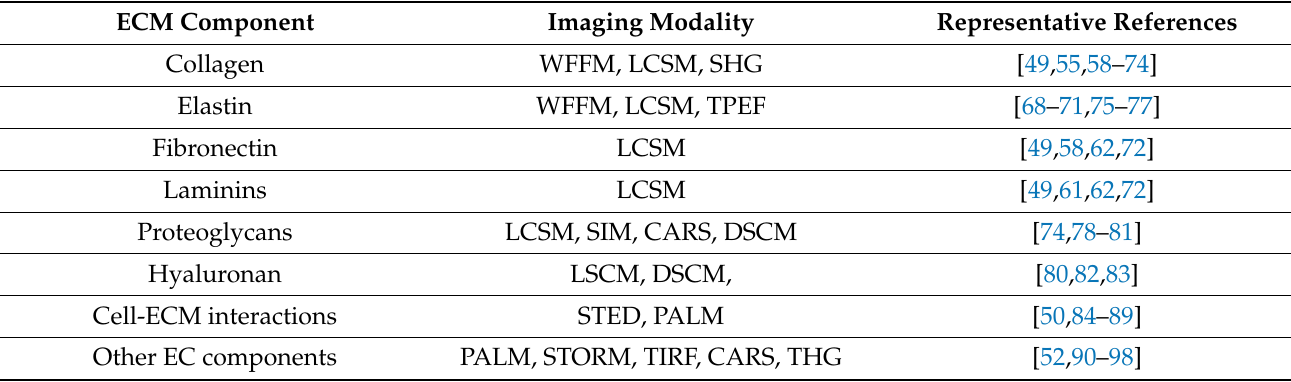
Figure 4. Representative multiphoton microscopy images. ( A – D ) Second-harmonic generation (SHG) optical sections of collagen from the four categories of ovarian tissues [55]. ( E – H ) Examples of two-photon emission fluorescence (TPEF) images of elastic fibers acquired from the regions along the aorta of myocardial infarction-prone Watanabe heritable hyperlipidemic rabbits [56]. ( I ) Simultaneous coherent anti-Stokes Raman scattering (CARS) imaging of axonal myelin and TPEF imaging of Oregon green 488 is represented by red and green colors. The grayscale inset image is an XZ image showing the cross-section of axons [57]. Images reproduced with permission from [55–57]. Table 4. Representative examples of applications of different microscopy modalities to assess ECM main